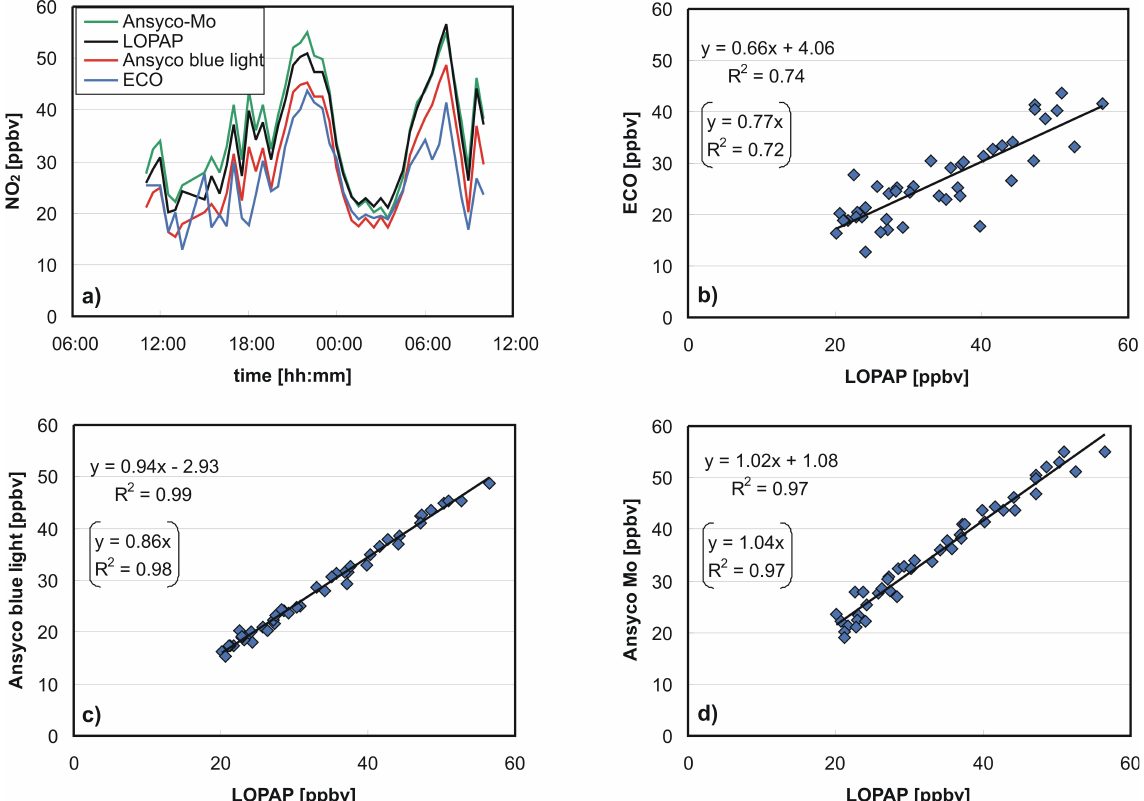
Fig. 3. (a) NO concentrations (30min averages) measured by different instruments in a street canyon; (b–d) correlation plots of the different 2 chemiluminescence instruments against the LOPAP data, which was used as reference here (see text). For the correlation equations given in brackets the intercept was forced to